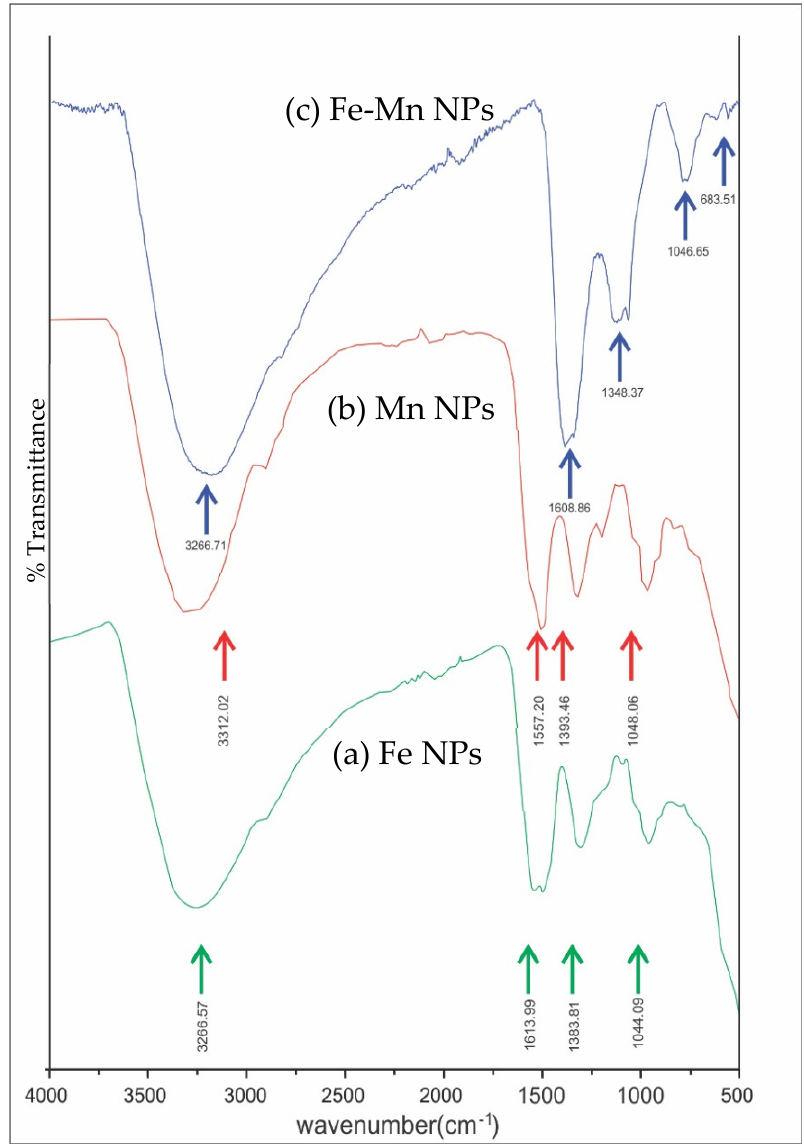
Figure 2. FTIR spectra of ( a ) Fe NPs, ( b ) Mn NPs ( c ) Fe-Mn NPs.